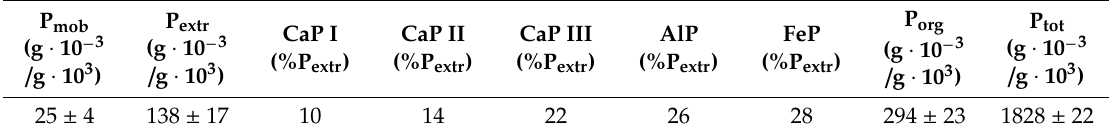
Table 1. Phosphorus in Haplic Cambisol soil before the experiment ( ± SD; Mehlich